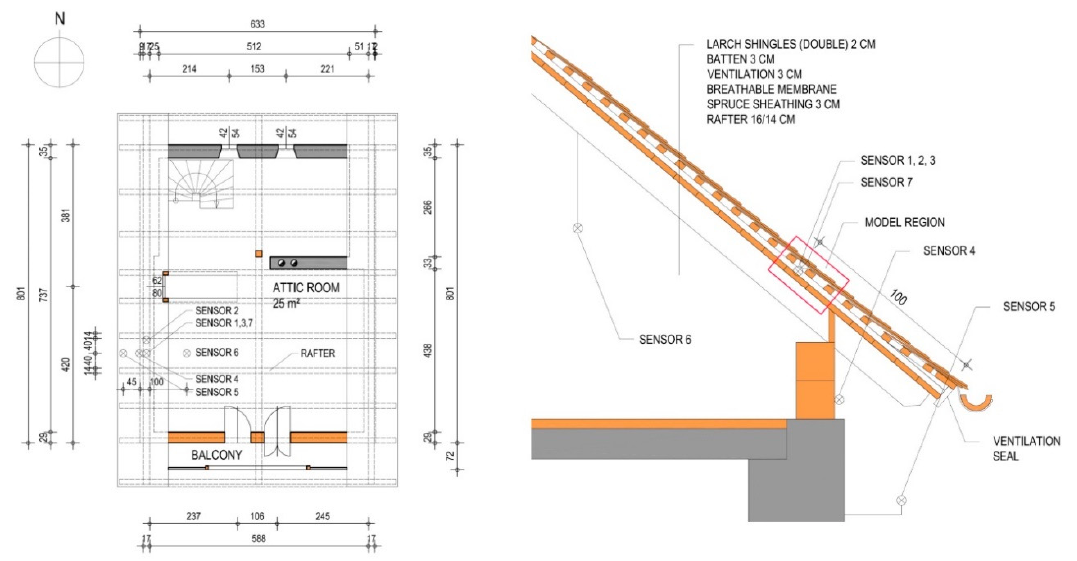
Figure 2. Floor plan and cross-section of the attic room with position of sensors and scope of the finite element (FE) model.